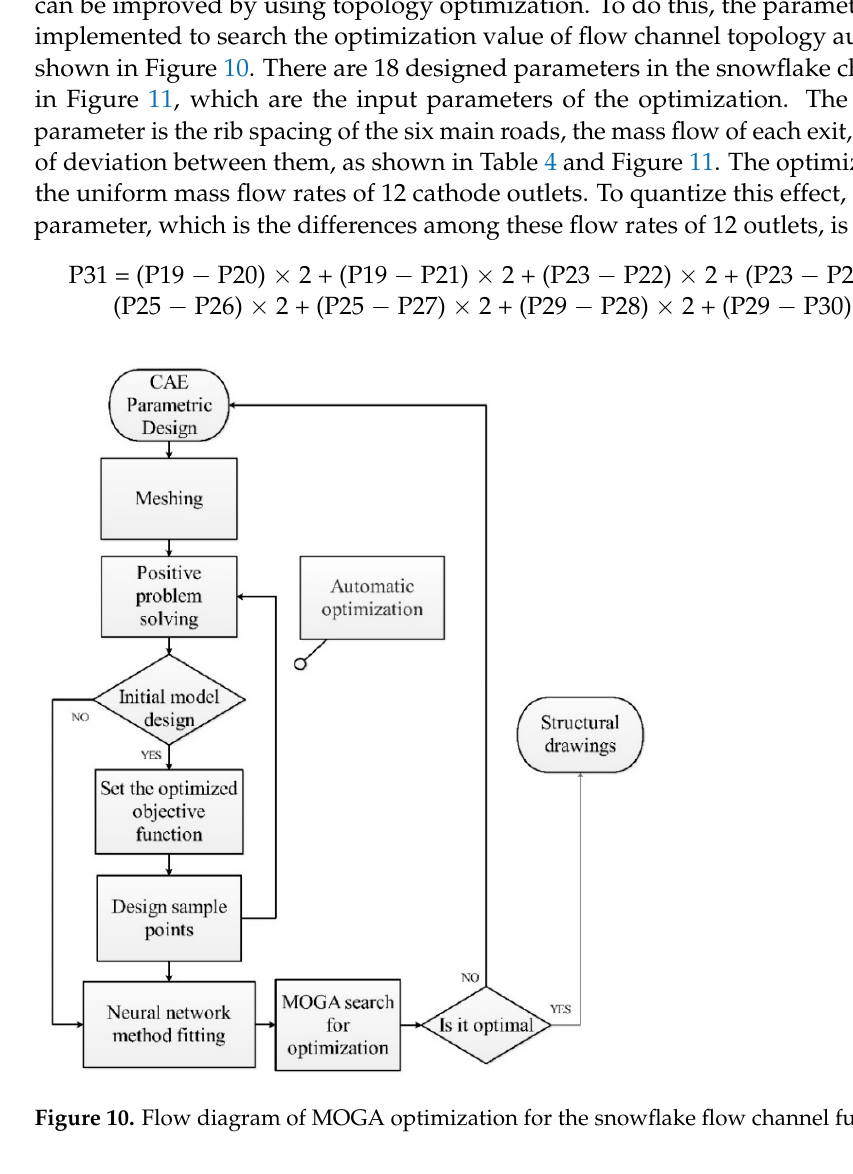
( b ) Figure 11. The MOGA optimization for snowflake flow channel fuel cell: ( a ) initial design parame- ters; ( b ) optimized parameters.